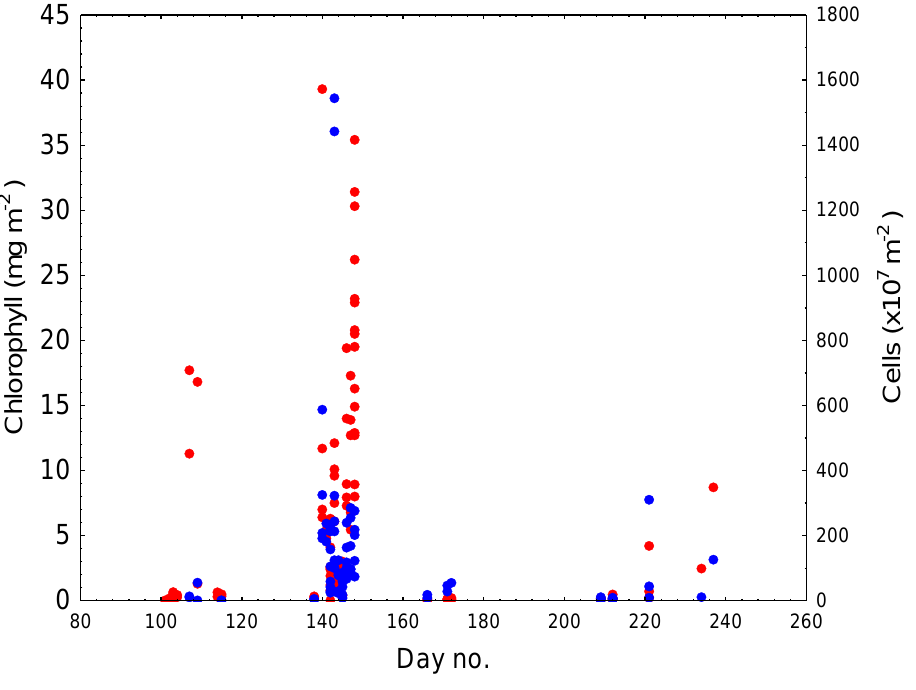
Figure 2. Temporal distribution of ice algal chlorophyll (mg m −2 ) (red) and cell numbers (cells × 10 7 m −2 ) (blue) in the Barents Sea pack ice 1986 –